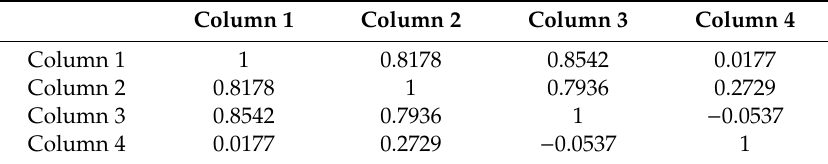
Table A2. Pearson correlation (see Table 1).